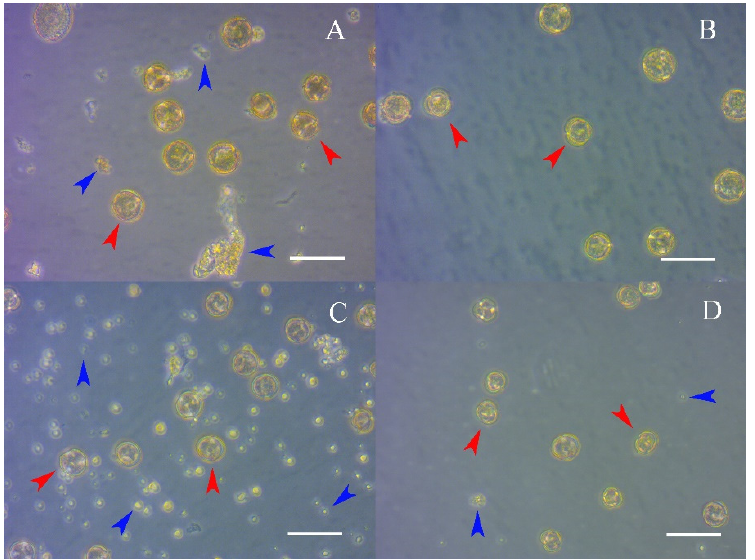
Figure 1. Preparations of spring radish ‘Ratnik’ ( A , B ) and European radish ‘RBK’ ( C , D ) under different isolation methods on the first day of cultivation. ( A , C )—isolation method № 2; ( B , D )—isolation method № 3. Red arrows are microspores; blue arrows are extrinsic grafts. Scale bars = 50 μ m.